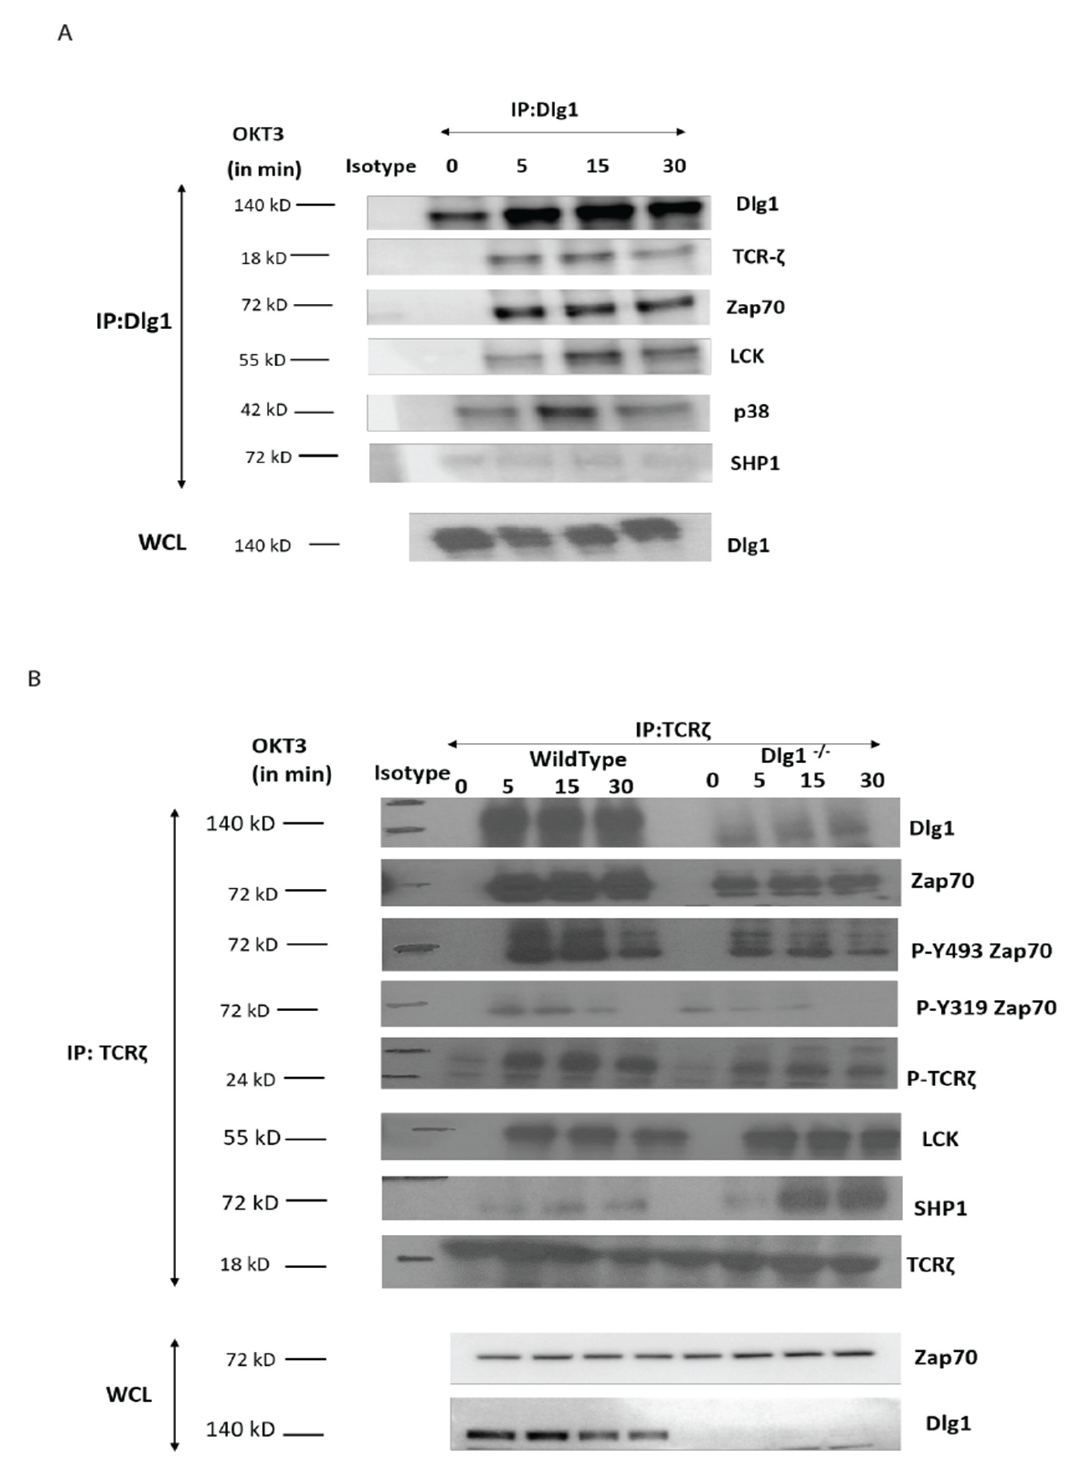
Figure 3. DLG1 is critical for ZAP70 recruitment to the TCR complex. ( A ). Immunoblot analysis (IB) of the indicated co-immunoprecipitated partners after immunoprecipitation (IP) of DLG1 from activated Jurkat cells. ( B ). Immunoblot analysis (IB) of the indicated co-immunoprecipitated partners after immunoprecipitation (IP) of TCR- ζ from activated wild-type and DLG1 KO Jurkat cells. Data are representative of three